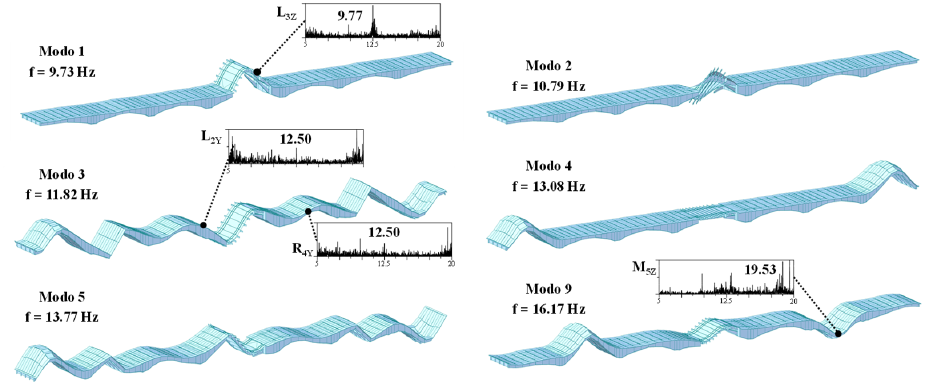
Figure 15. Modal shapes corresponding to the main modes reported in Table 8.